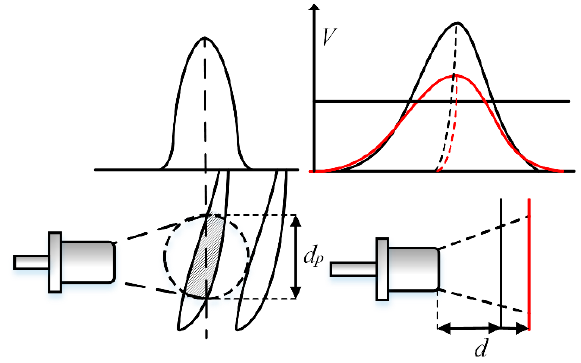
Figure 6. Sketch of received tip signal under different tip clearances.